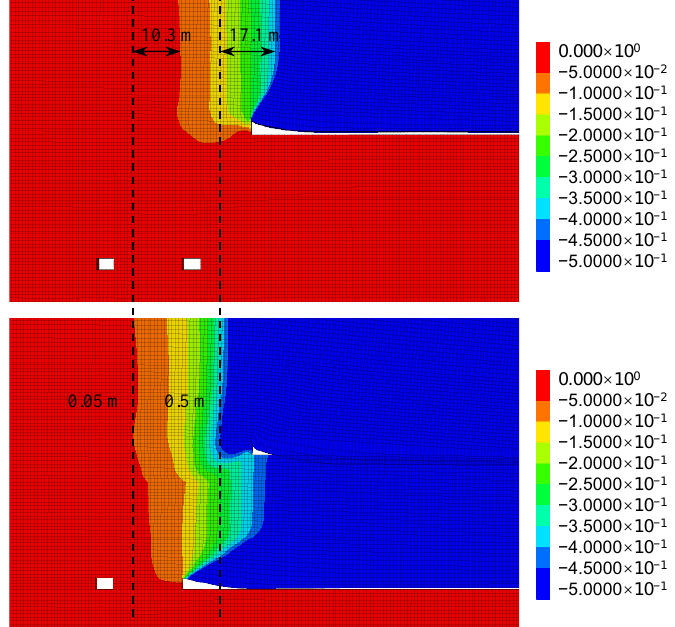
Figure 11. Distribution of roof displacement in different mining stages.